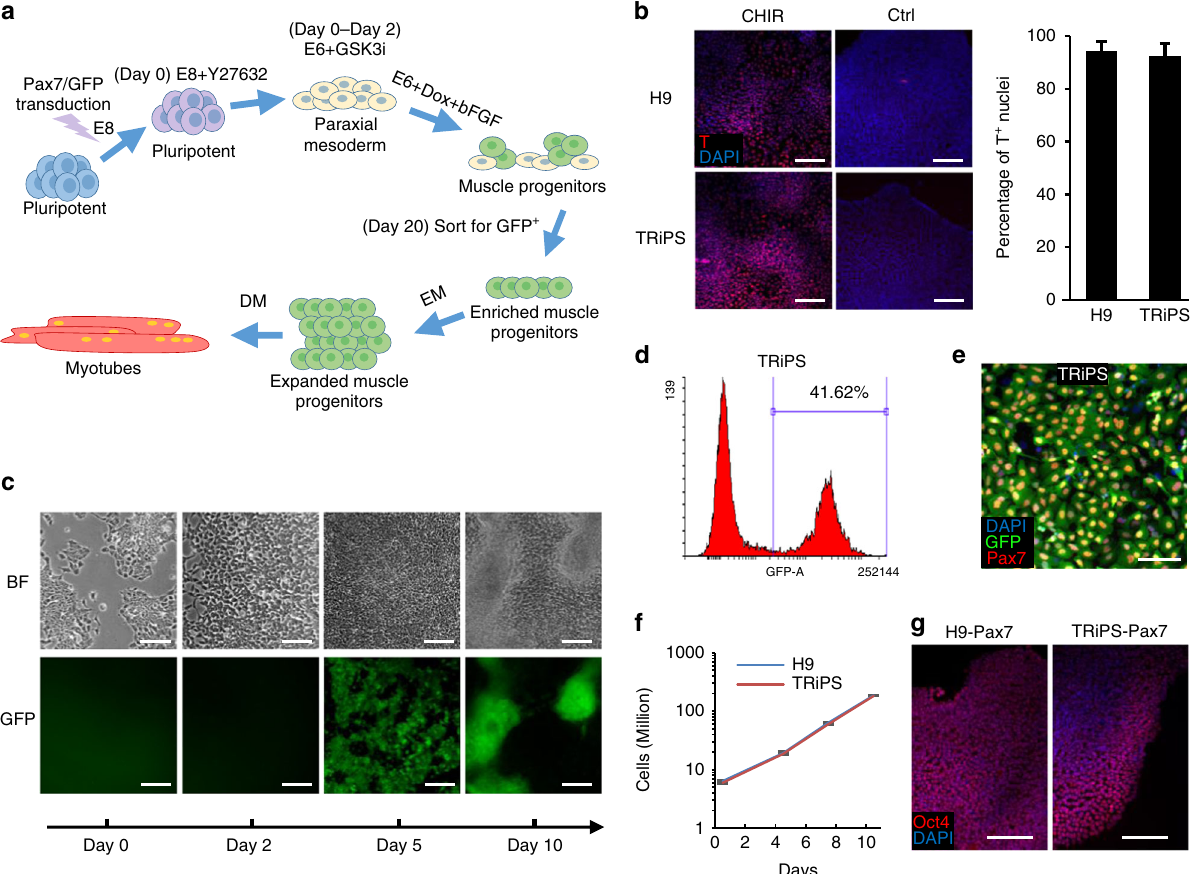
Fig. 1 Derivation of Pax7 + myogenic progenitors from hPSCs. a Schematics of differentiation procedure from hPSCs to myotubes. Dox doxycycline, EM expansion media, DM differentiation media. b Representative immunostaining and quanti fi cation of early mesodermal marker, T, at Day 2 of differentiation. Scale bar = 100 µ m ( n = 6 samples from 3 differentiations for each cell line). c Representative images showing changes in cell morphology during fi rst 10 days of differentiation. Scale bar = 100 µ m. d Representative FACS analysis at Day 20 when GFP + cells were sorted out for subsequent expansion. e Representative immunostaining of GFP and Pax7 in TRiPS derived progenitors at day 4 of expansion. Scale bar = 50 µ m. f Growth curve of hPSCs derived muscle progenitors during expansion ( n = 9 samples from three expansions for each cell line). g Representative immunostaining of pluripotent marker Oct4 in Pax7/GFP transduced H9 and TRiPS cells after freezing and thawing. Scale bar = 100 µ m. Data are presented as mean ±